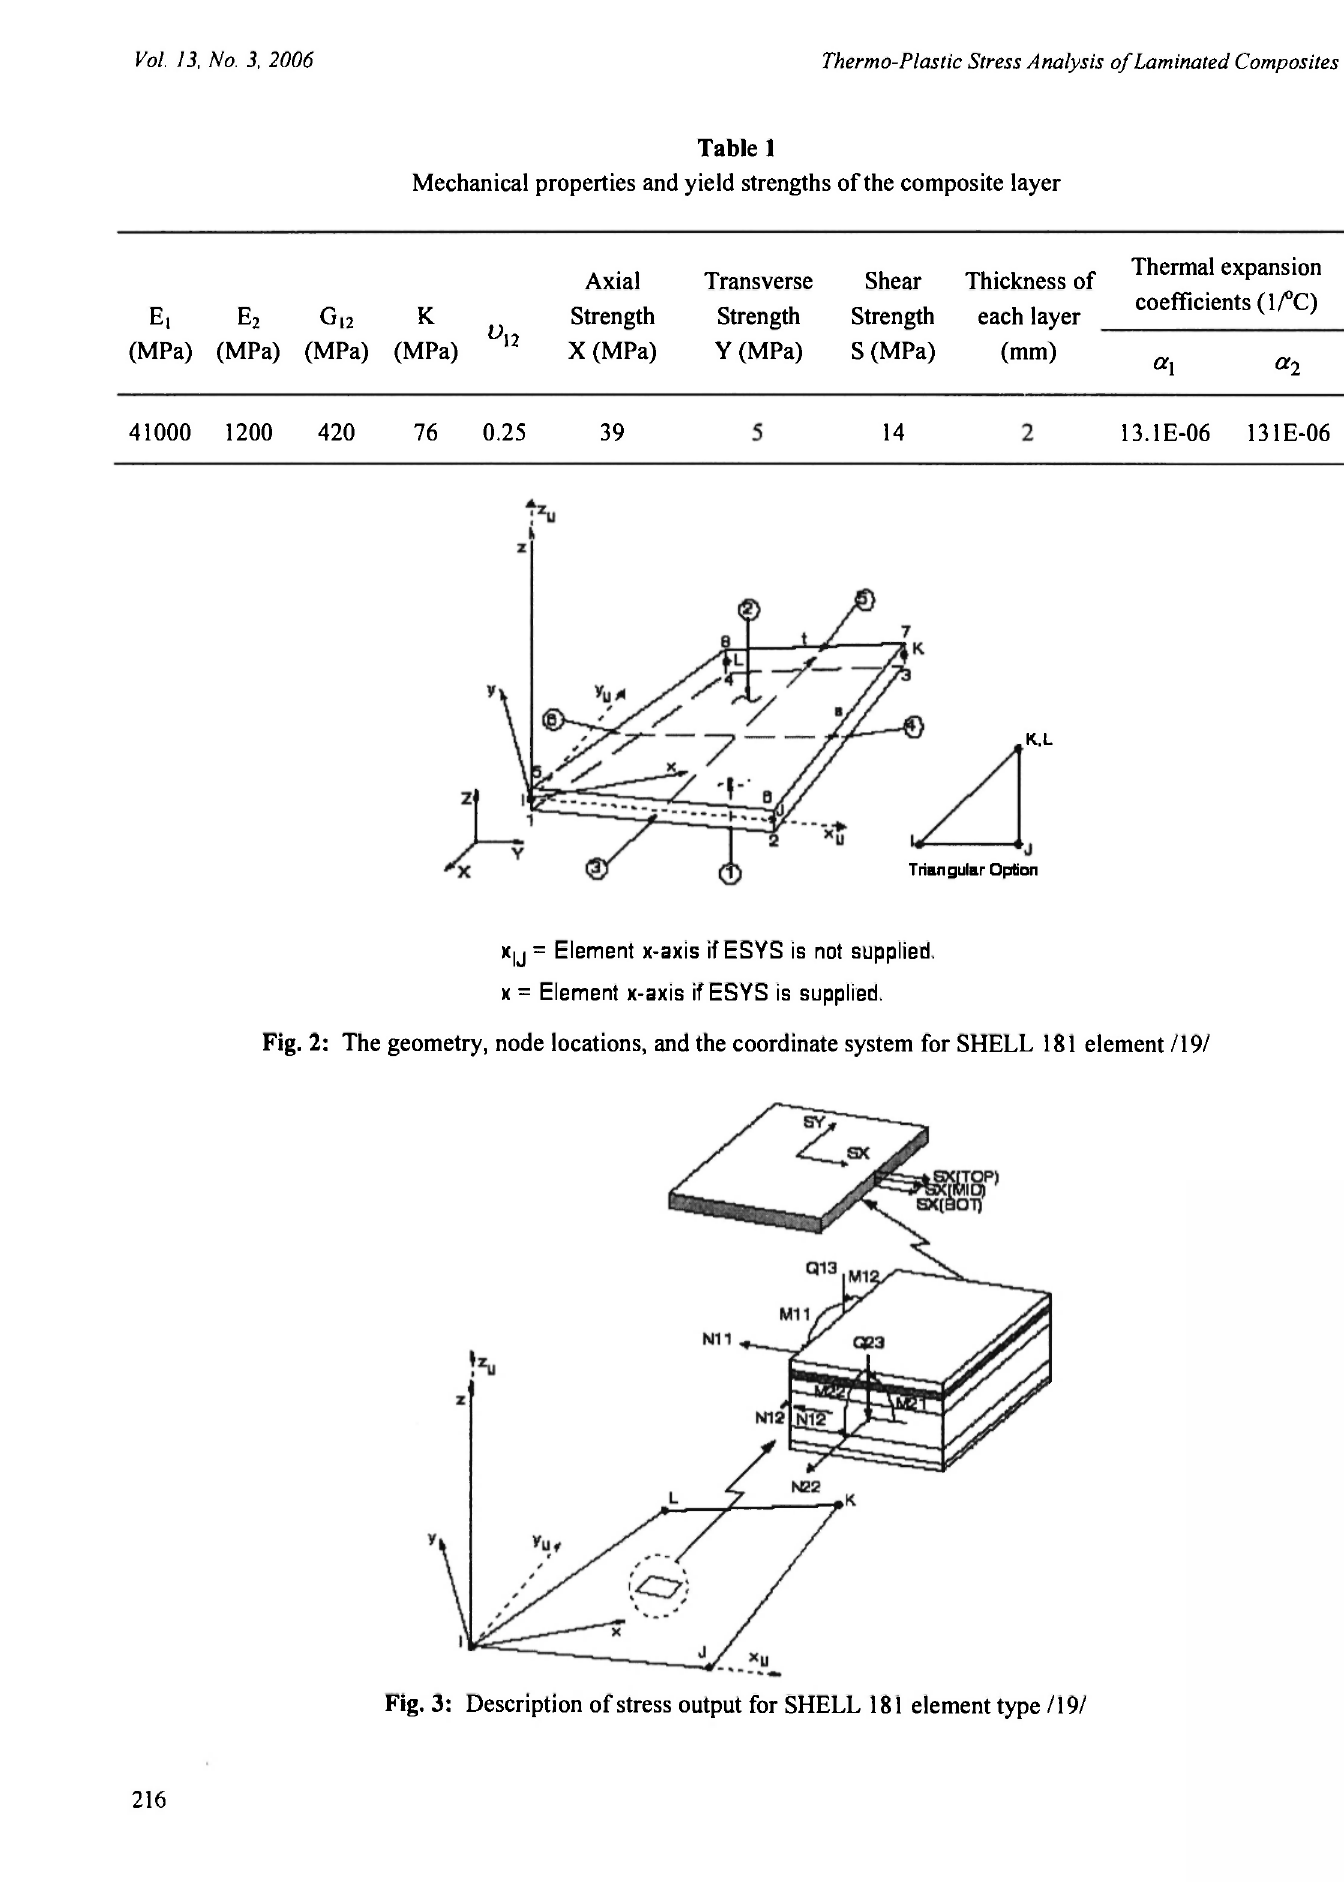
Fig. 3: Description of stress output for SHELL 181 element type